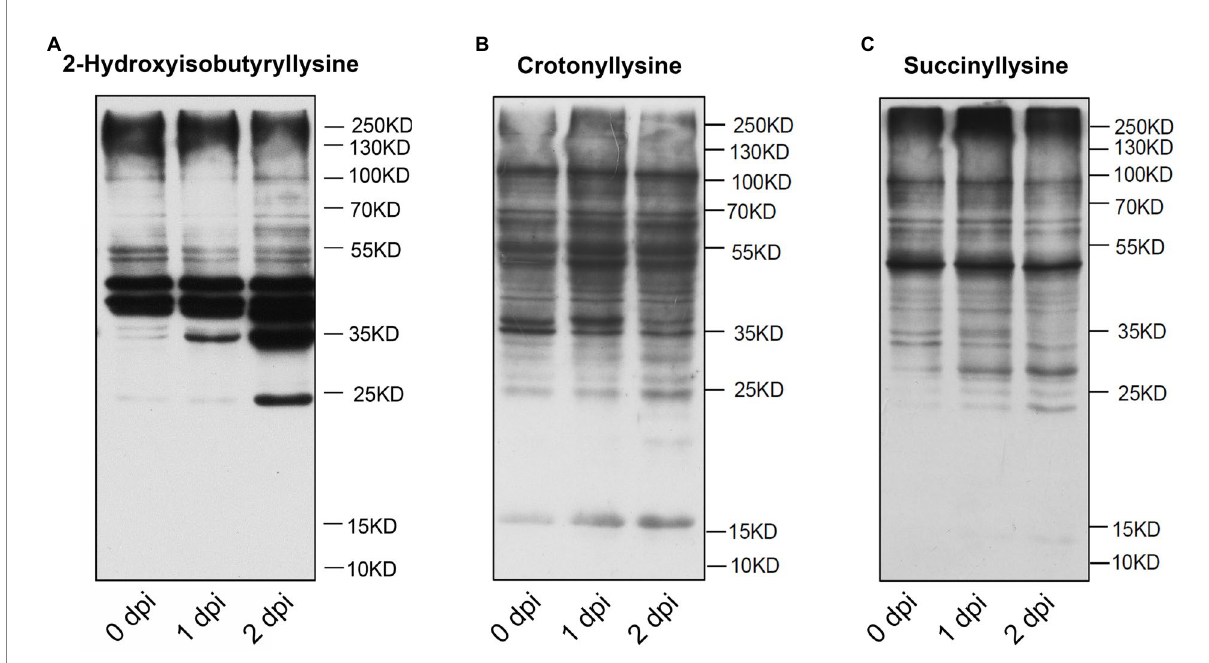
FIGURE 1 Immunoblotting analysis of total protein 2-hydroxyisobutyrylation (Khib) (A) , crotonyllysine (Kcr) (B) , succinyllysine (Ksucc) (C) levels during Fusarium graminearum infection in maize stems.